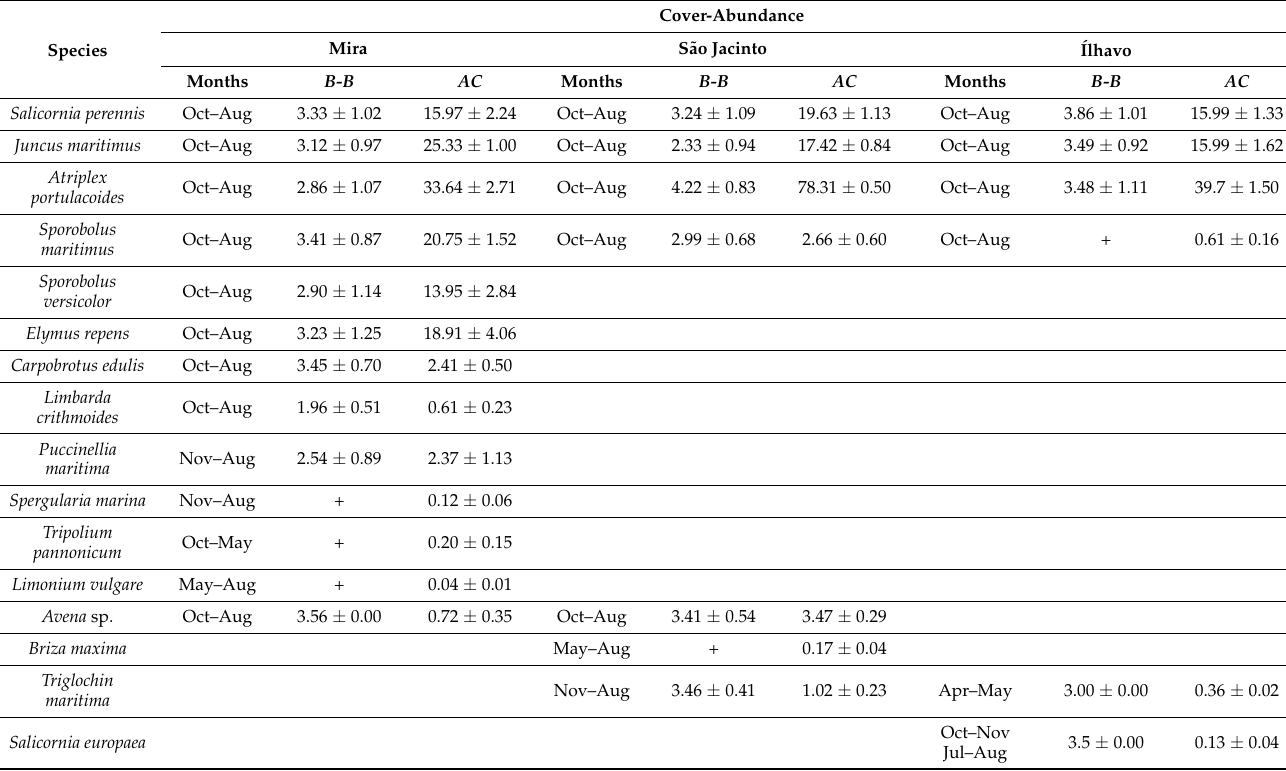
Table A1. Summary table with the mean overall coverage-abundance Braun-Blanquet ( B-B ) and average cover ( AC ) values attained by all the species encountered throughout the year (and their respective standard deviation). Scientific names according to POWO (https://powo.science.kew.org/, accessed on 25 January 2023). The symbol “+” refers to low coverage with few